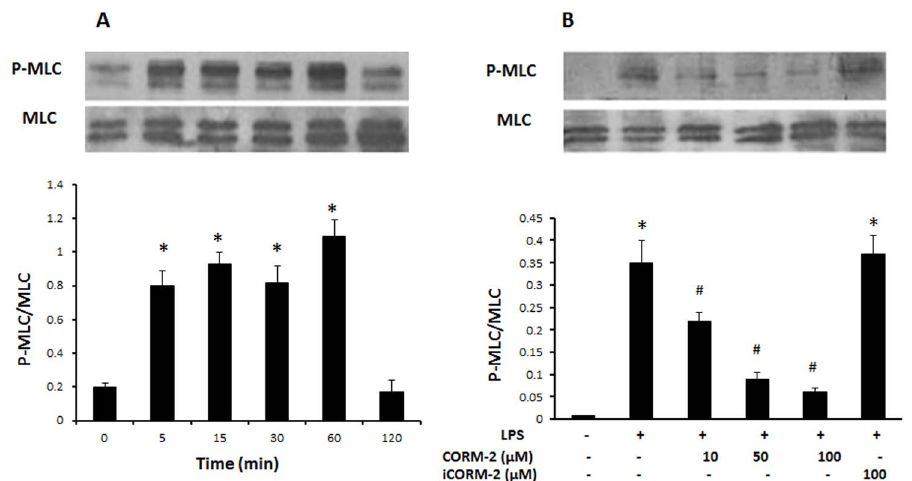
Figure 5. Effect of CORM-2 on the levels of MLC phosphorylation. (A) IEC-6 cells were treated with 50 m g/ml LPS and harvested at different time points. MLC phosphorylation (p-MLC) was detected using phosphorylation-specific antibody. Sample loading was normalized using anti-MLC antibody. A typical blot is shown (Upper panel). (B) IEC-6 cells were pretreated with CORM-2 for 1 h followed by LPS (50 m g/ml) treatment for 1 h. A typical Western blot shows that CORM-2 reduced LPS-enhanced MLC phosphorylation (Upper panel). The relative ratios (Mean 6 SD) of p-MLC/MLC are calculated based on the densities of bands on Western blots from 3 independent experiments (Lower panels of (A) and (B)). *ANOVA test, P , 0.05 when compared to control group (no treatment), # ANOVA test, P , 0.05 when compared to LPS alone group.